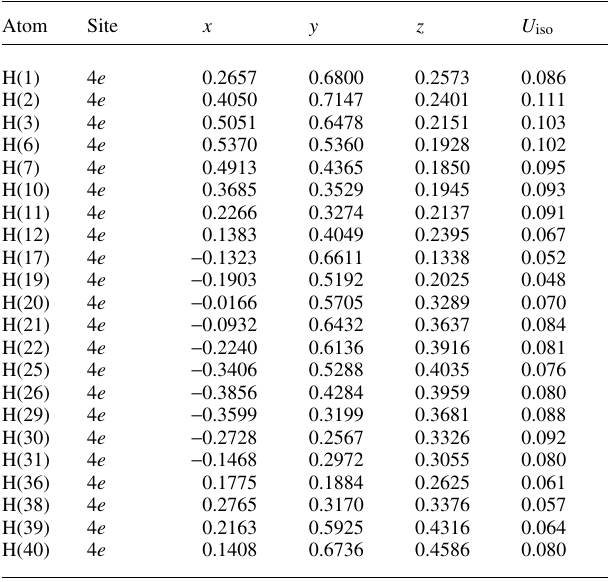
Table 2. Atomic coordinates and displacement parameters (in Å 2 ) .